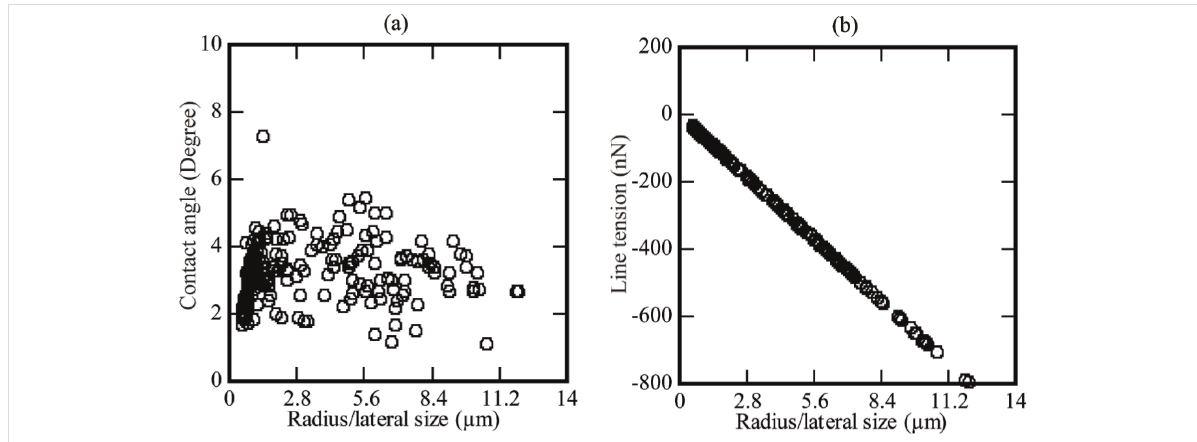
Figure 3: (a) Summary of the contact angle versus the radius/lateral size of the spherical objects. (b) Summary of the line tension of the spherical objects on PS-coated surfaces.